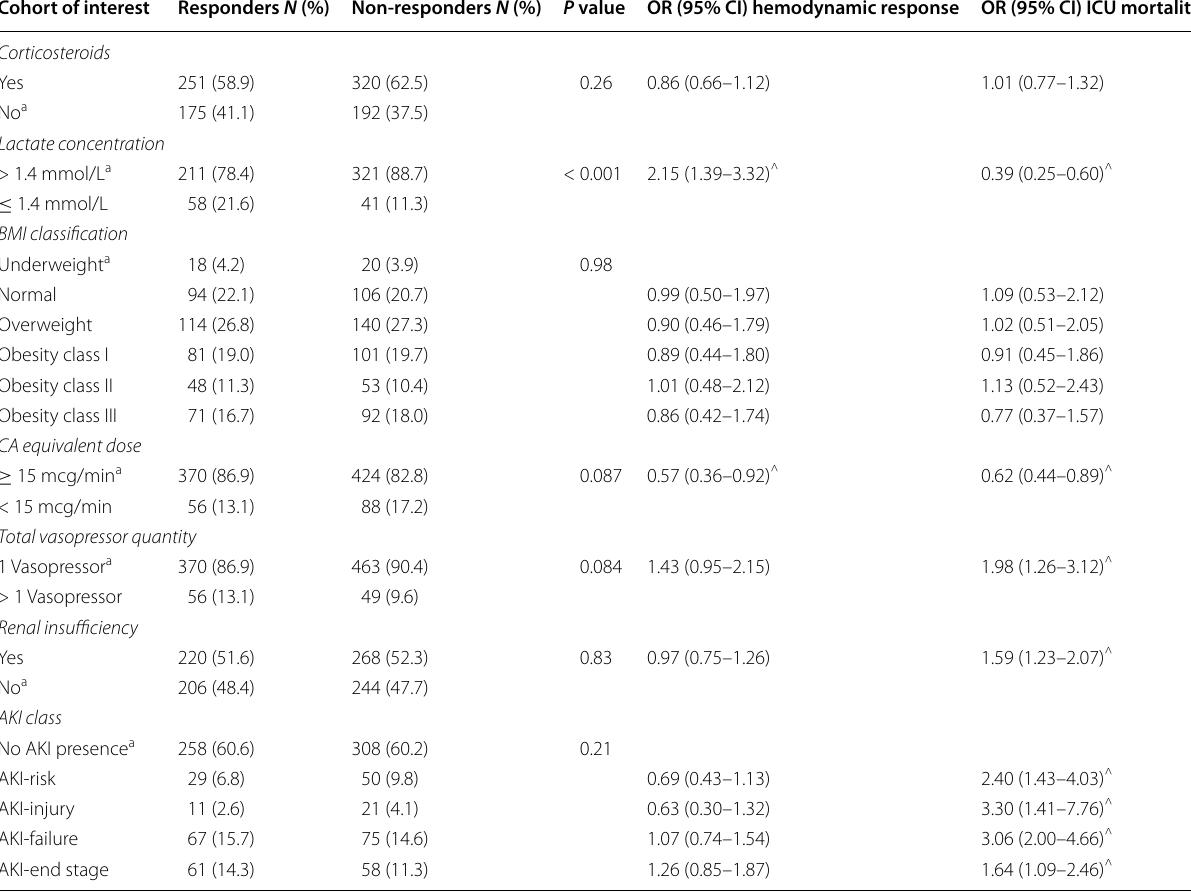
Table 4 Predefined cohorts of